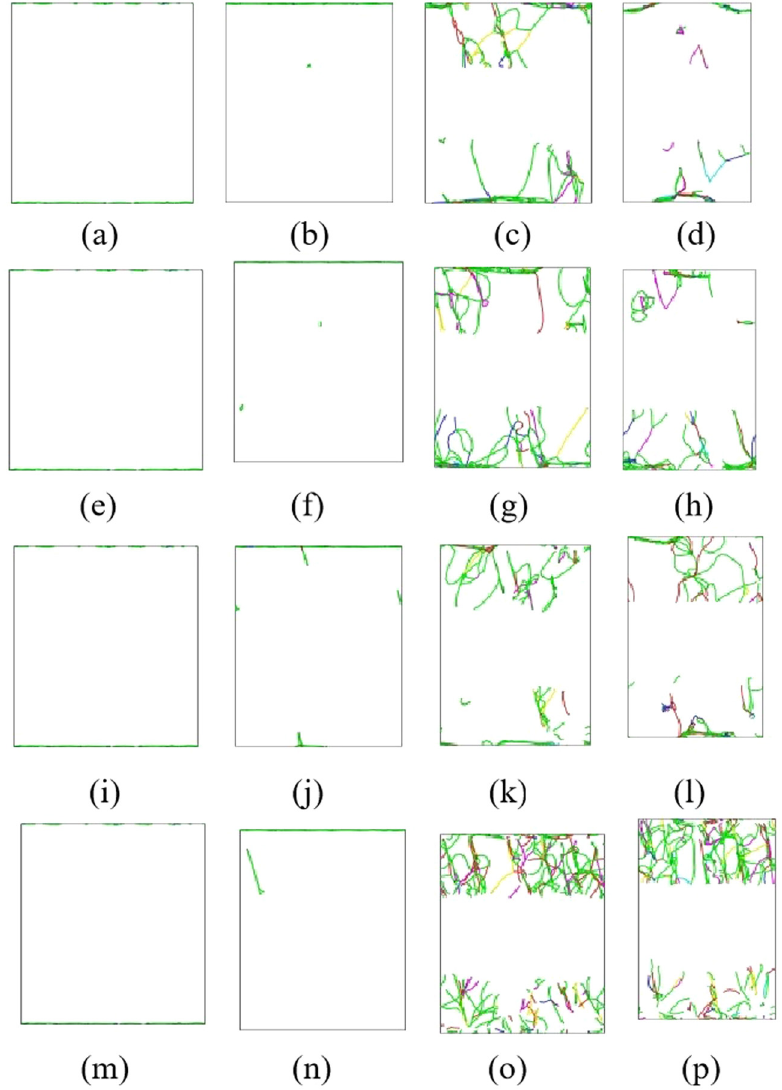
Figure 6: The distribution of the dislocation lines with respect to the marked points in the stress – strain curve ( Figure 5 ) . ( a – d ) 0.0005 ps − 1 ; ( e ) – ( h ) 0.001 ps − 1 ; ( i – l ) 0.005 ps − 1 ; and ( m – p ) 0.01 ps − 1 . ( a ) point a1, ( b ) point b1, ( c ) point c1, ( d ) point d1, ( e ) point a2, ( f ) point b2, ( g ) point c2, ( h ) point d2, ( i ) point a3, ( j ) point b3, ( k ) point c3, ( l ) point d3, , ( m ) point a4, ( n ) point b4, ( o ) point c4, ( p ) point